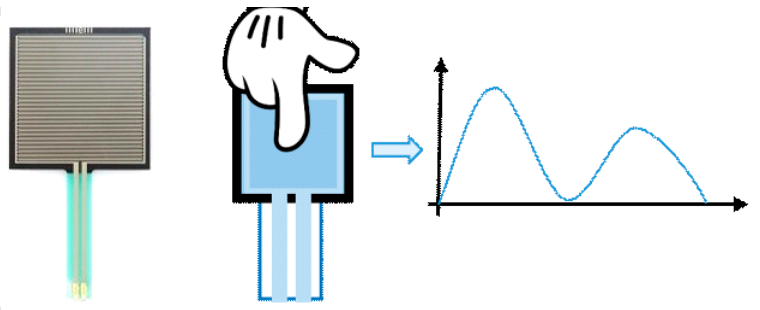
Figure 6. The pressure